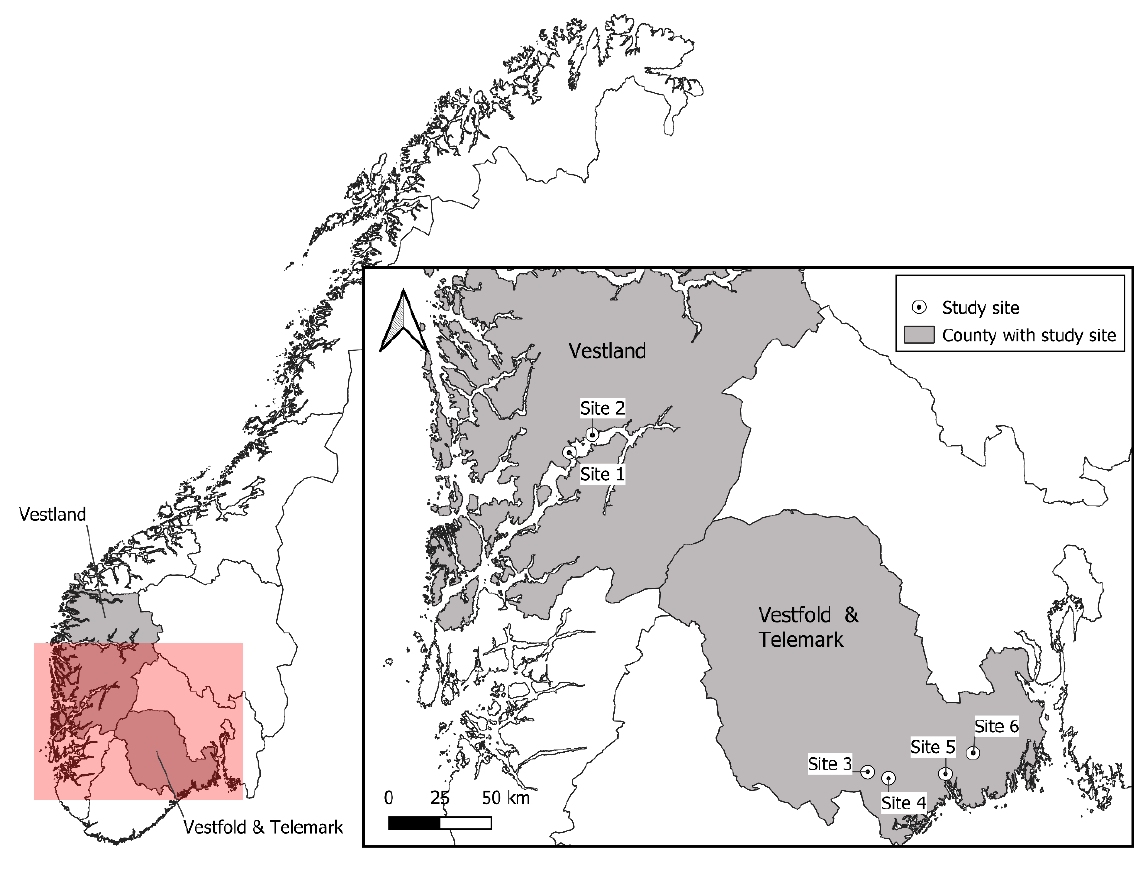
Figure 1. Site overview. Table 1. Site details .